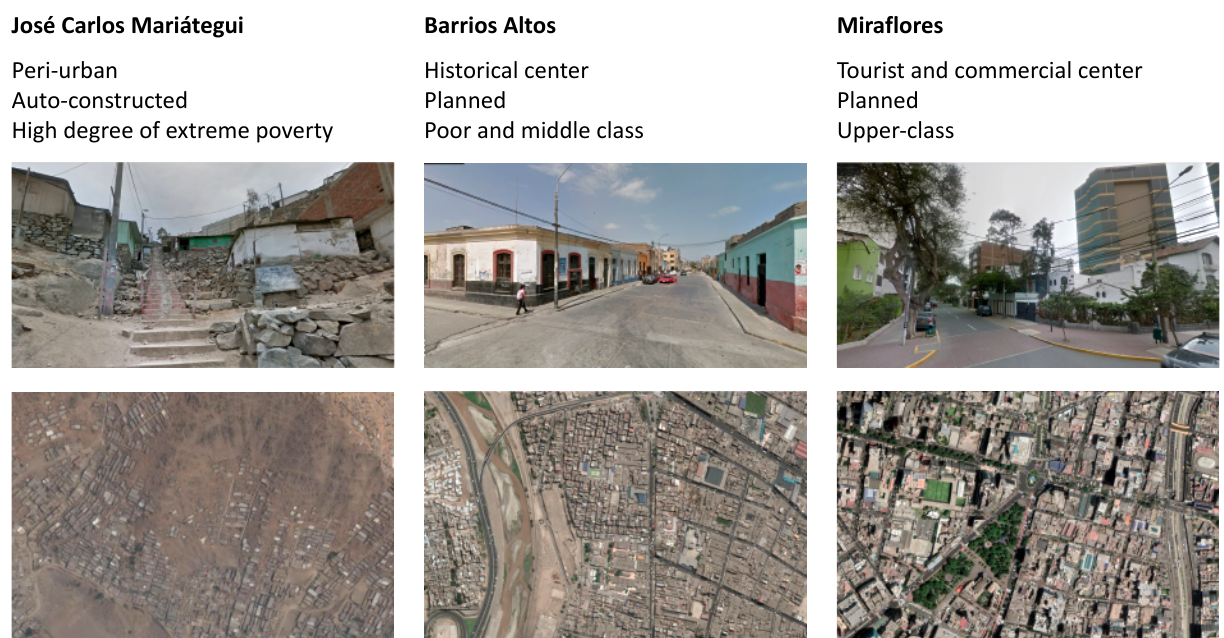
Figure 1. Areal and street views of the three research areas. Source: Google Earth and Google Maps. ferent strands of government, academia, and civil society groups. The second expert meeting was with researchers and engineers of SEDAPAL. The focus groups and expert meetings lasted between one and two-and-a-half hours and were recorded and